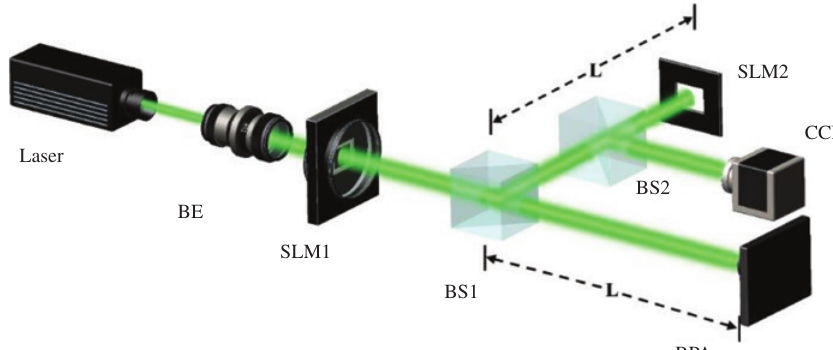
Figure 3: Experimental setup for generating an anomalous Bessel vortex beam and measuring its phase patterns. BE, beam expander; SLM1 and SLM2, spatial light modulators; BS1 and BS2, beam splitters; BPA, beam profile analyser; CCD, charge-coupled